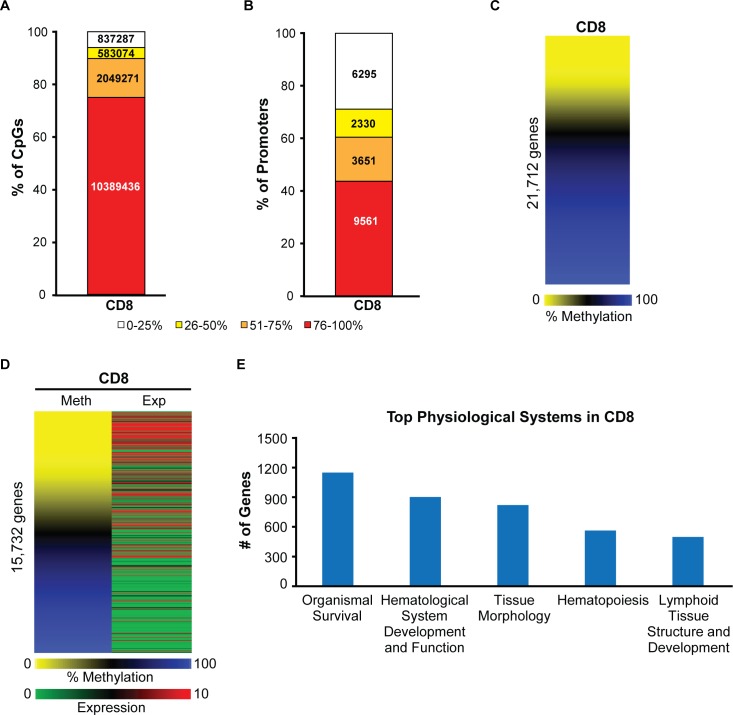
A majority of promoters are methylated and inactive in normal mouse CD8+ T cells.(A) CpG methylation in wild-type CD8+ cells, as determined by WGBS. Individual CpGs were placed into quartiles based on percent methylation (0–25%, 26–50%, 51–75%, and 76–100%). (B) Percent methylation shown by quartiles for core promoter regions (-300bp to +150bp relative to the TSS) in wild-type CD8+ cells. Methylation percentages for all CpGs across the 450bp region were averaged to give a mean methylation value for each gene’s core promoter. (C) A heat map displaying methylation status of 21,712 promoters in wild-type CD8+ as determined by WGBS. Methylation percentage for individual CpGs were annotated to the promoter regions −300bp to +150bp relative to the transcription start site (TSS). Methylation percentages for all CpGs across the 450bp region were averaged to give a mean methylation value for each gene promoter. Lowly methylated promoters are shown in yellow and highly methylated promoters in blue (D) Heat map presentation of gene-matched promoter methylation (as analyzed in panel C) and corresponding transcriptional expression (averaged FPKM values) in wild-type CD8+ cells, as determined by WGBS and RNA-seq for 15,732 genes. Highly expressed genes are denoted in red and lowly expressed genes are denoted in green. (E) Ingenuity Pathway analysis (IPA) of highly expressed genes (FPKM ≥ 10) in wild-type CD8+ cells. The top subcategories obtained in Physiological System, Development and Functions are displayed (P<0.05, for all subcategories).